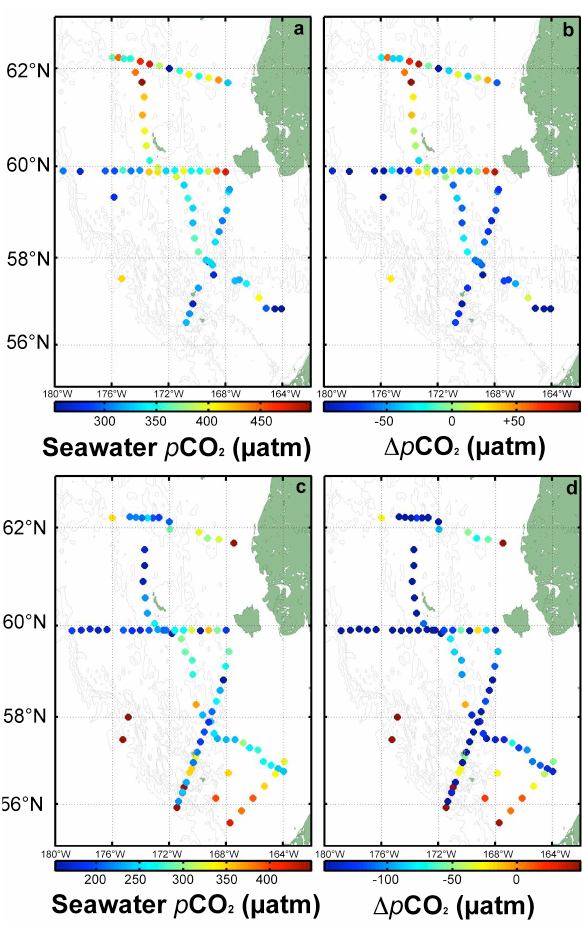
Figure 5 . Surface seawater p CO 2 (calculated from DIC and TA) and Δ p CO 2 values observed Fig. 5. Surface seawater p CO 2 (calculated from DIC and TA) and at hydrocast stations in spring and summertime during the 2008 BEST program. a . Calculated 1p CO 2 values observed at hydrocast stations in spring and sum- surface seawater p CO 2 during the 2008 spring BEST cruise; b . Calculated seawater Δ p CO 2 mertime during the 2008 BEST program. (a) Calculated surface station during the 2008 spring BEST cruise; c . Calculated seawater p CO 2 during the 2008 seawater p CO 2 during the 2008 spring BEST cruise; (b) Calculated summer BEST cruise; d . Calculated seawater Δ p CO 2 during the 2008 summer BEST cruise. seawater 1p CO 2 station during the 2008 spring BEST cruise; (c) Calculated seawater p CO 2 during the 2008 summer BEST cruise; (d) Calculated seawater 1p CO 2 during the 2008 summer BEST cruise.